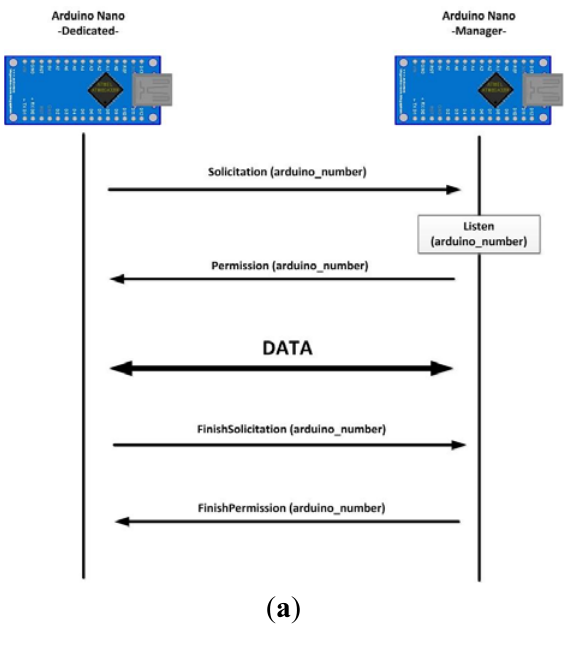
Figure 7. ( a ) Prototype of a cybernetic table; ( b ) Electronic scheme of the cybernetic